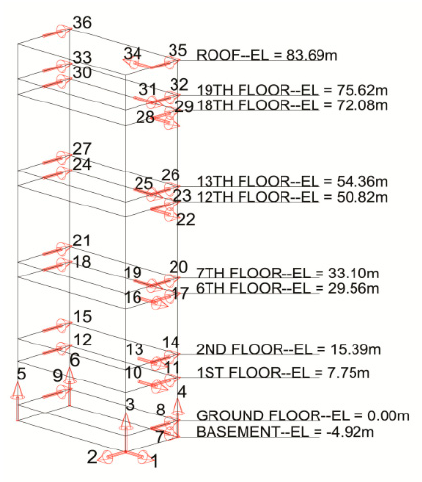
Figure 3. Distribution and orientation of USGS accelerometers within the Green Building.